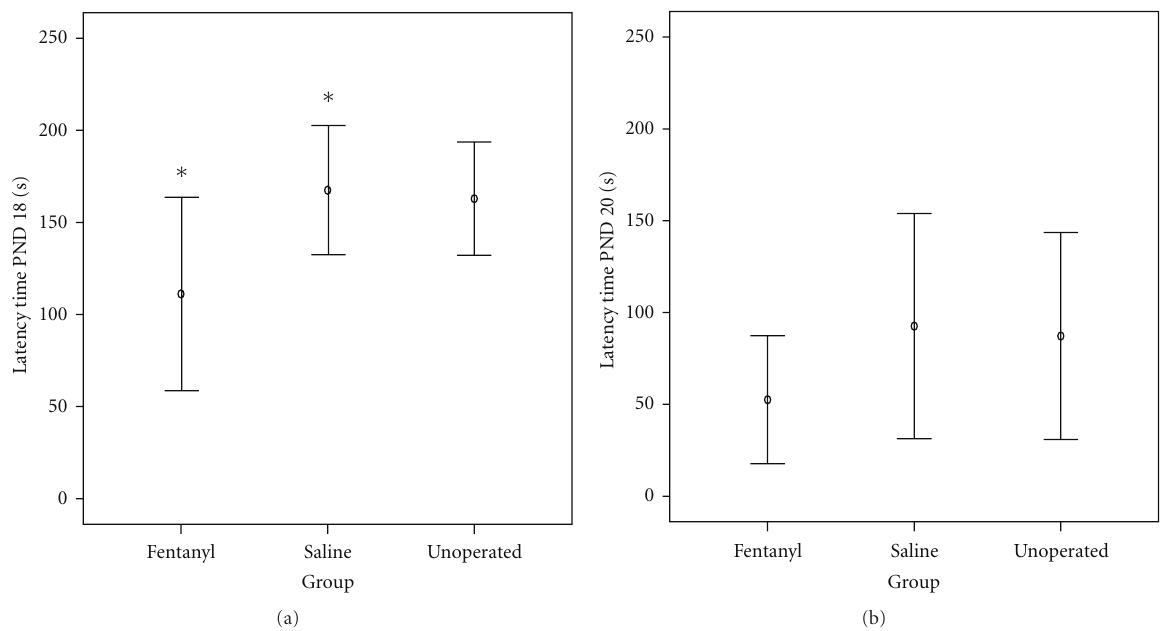
Figure 4: Latency times to complete the task of reaching the platform in the wire hanging maneuver on (a) postnatal day 18 and (b) postnatal day 20. Both on PND 18 and 20, rats in the fentanyl group were faster than controls, with statistical di ff erence to the saline group ( ∗ P = 0 . 035) on PND 18. Values represent mean and 95% confidence interval for